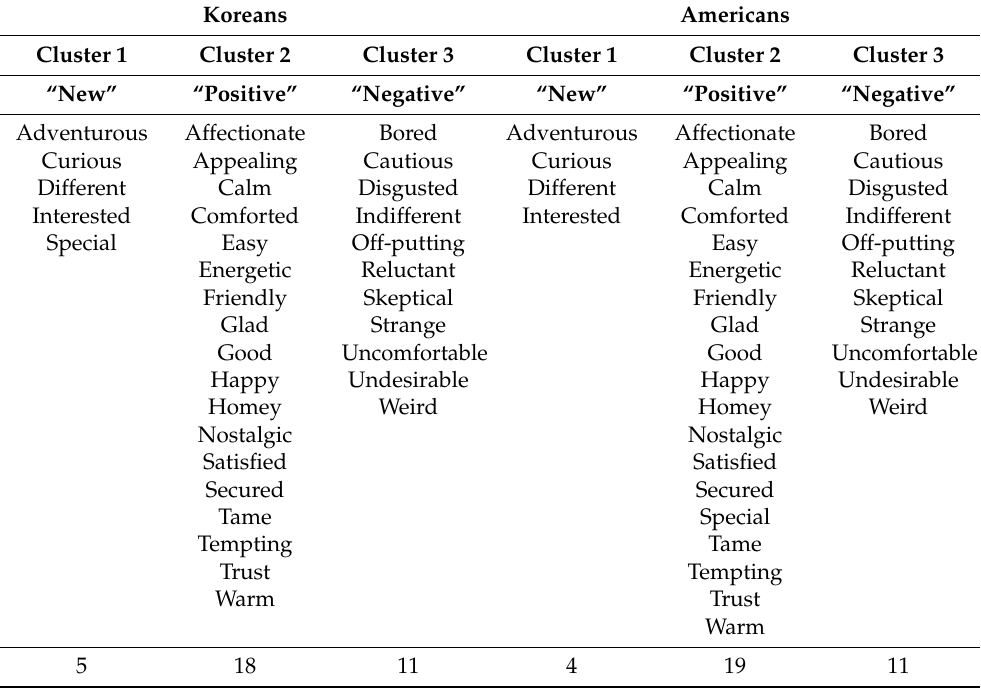
Table 7. Classification of the emotion lexicons in the Korean and American